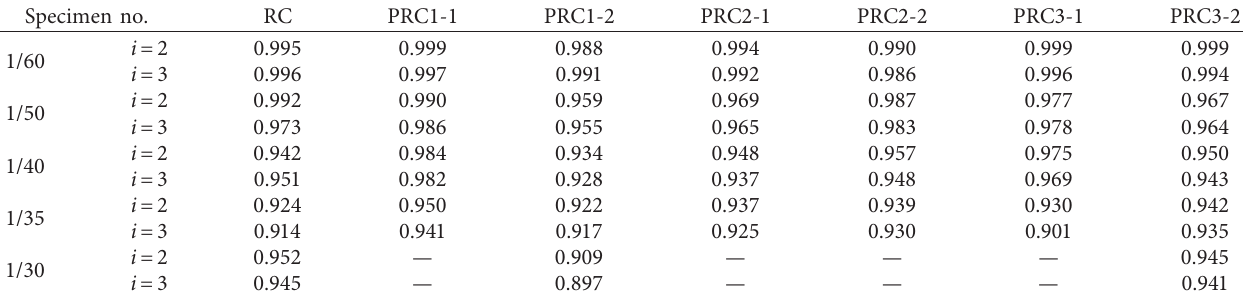
i of each specimen under different displacement amplitudes.